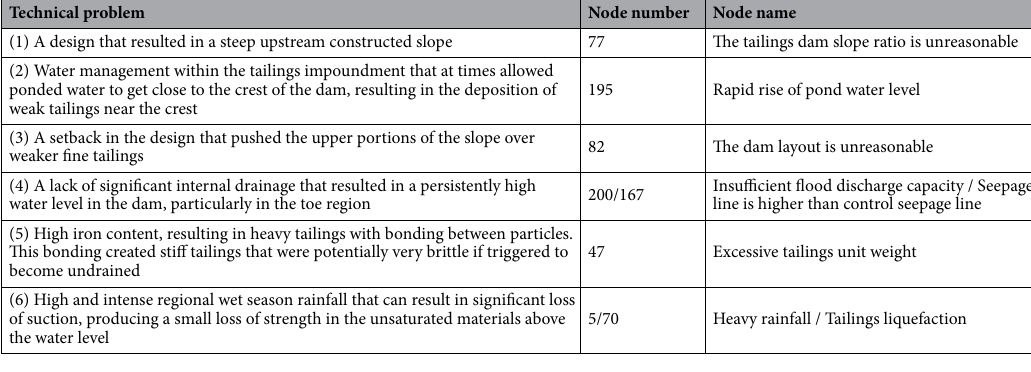
Table 2. Key hazard comparison table.